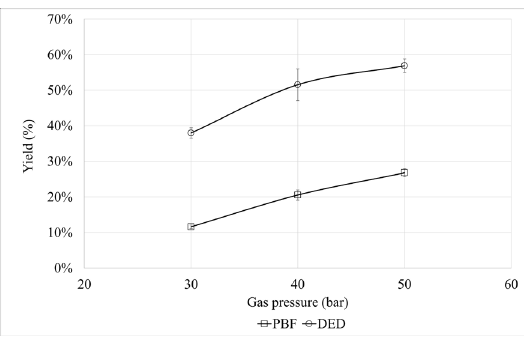
Figure 11. Powder yield accounted for the particle sizes ranges required for DED and PBF processes as a function of gas pressure.